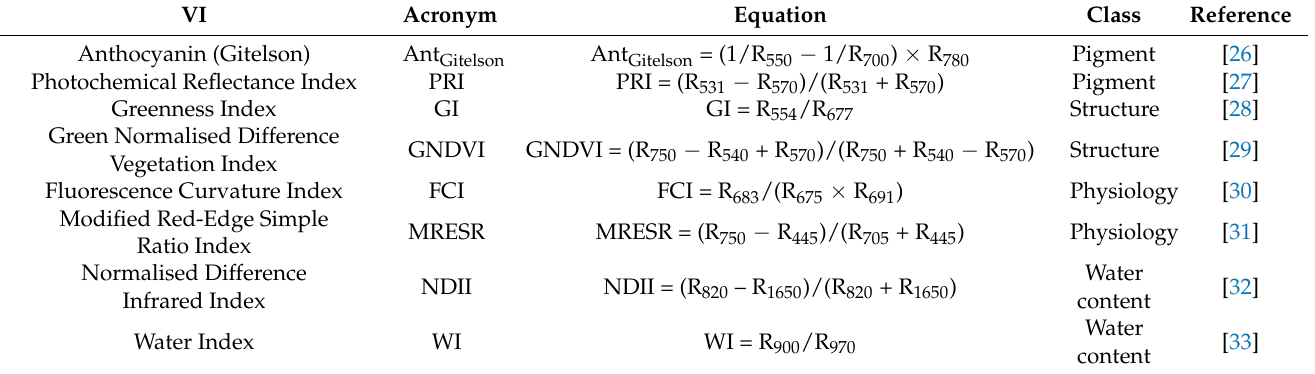
Table 2. Summary table of the treatments applied in this experiment. Day and night temperatures were set at 40 ◦ C and 30 ◦ C,